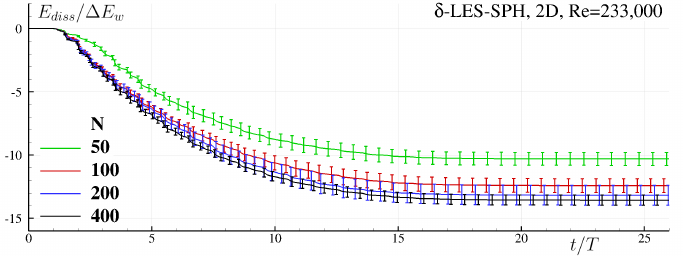
Figure 6. Test with water: ensemble average of the energy dissipation E diss time history for different spatial resolutions. Error bars refer to the computed standard